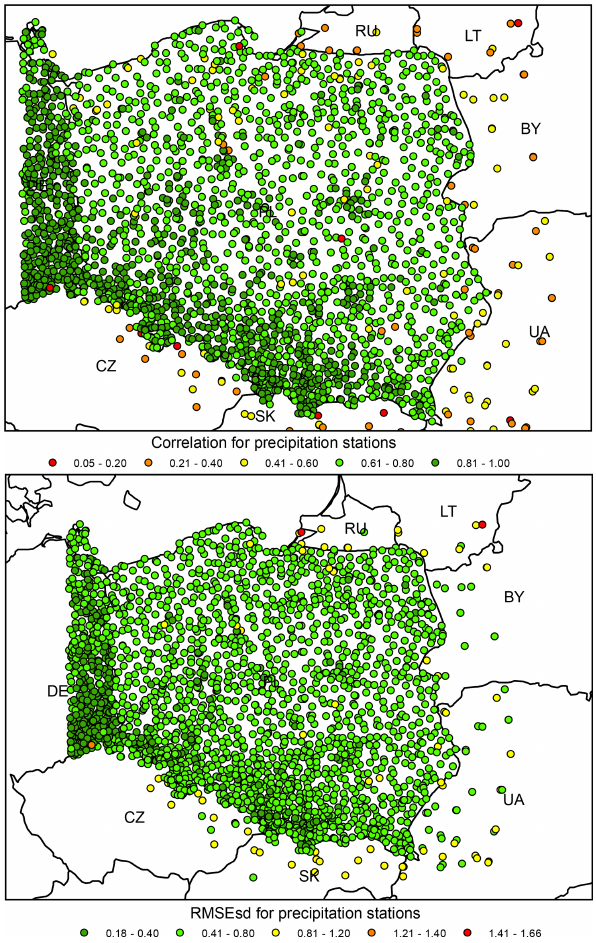
Figure 12. Precipitation ρ (top) and RMSEsd (bottom) values calculated for stations in the period 1951–2019. National borders (black lines) are labelled with country codes.